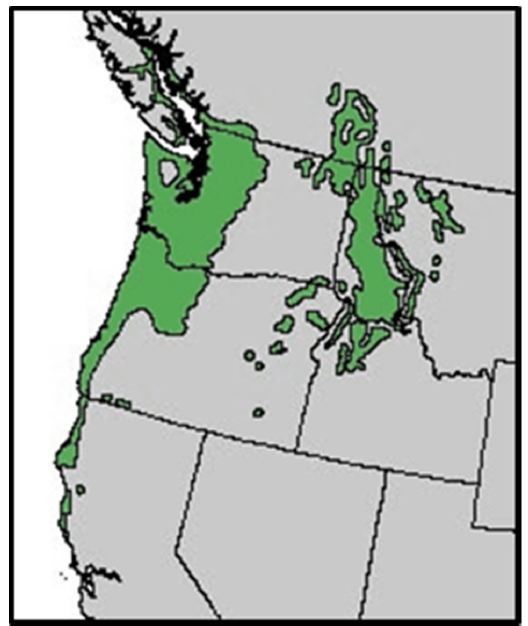
Figure 1. Range map of grand fir in the Pacific Northwest [6].